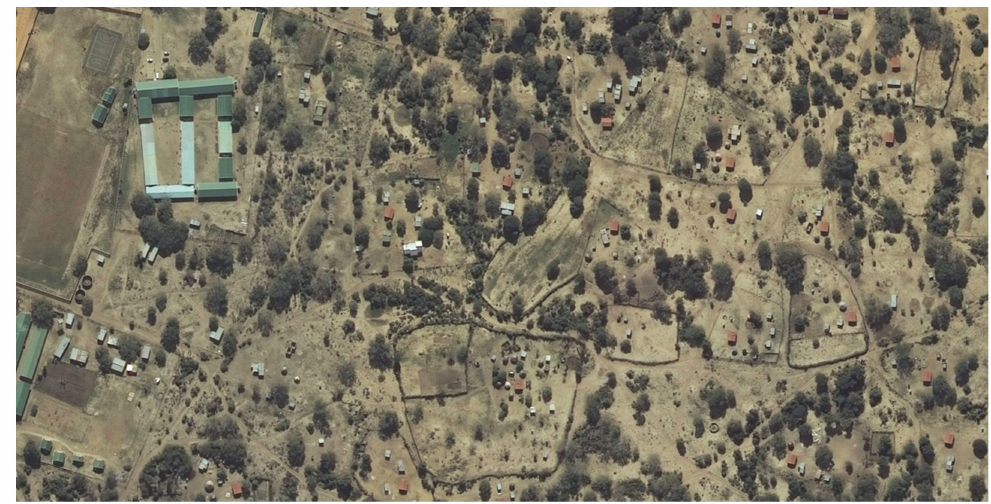
Figure 9. Extract from 2019 rectified imagery [12] (Ref: 2732 AB 15), showing part of a rural settlement in an area known as Siphondweni, on communal land in the KwaZulu-Natal Province, at scale: 1:5000